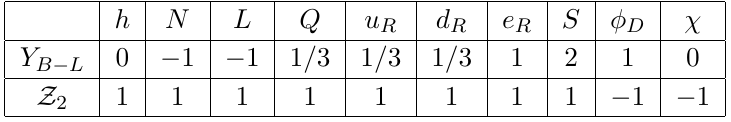
Table 1 . Charges of all the particles under B − L and Z 2